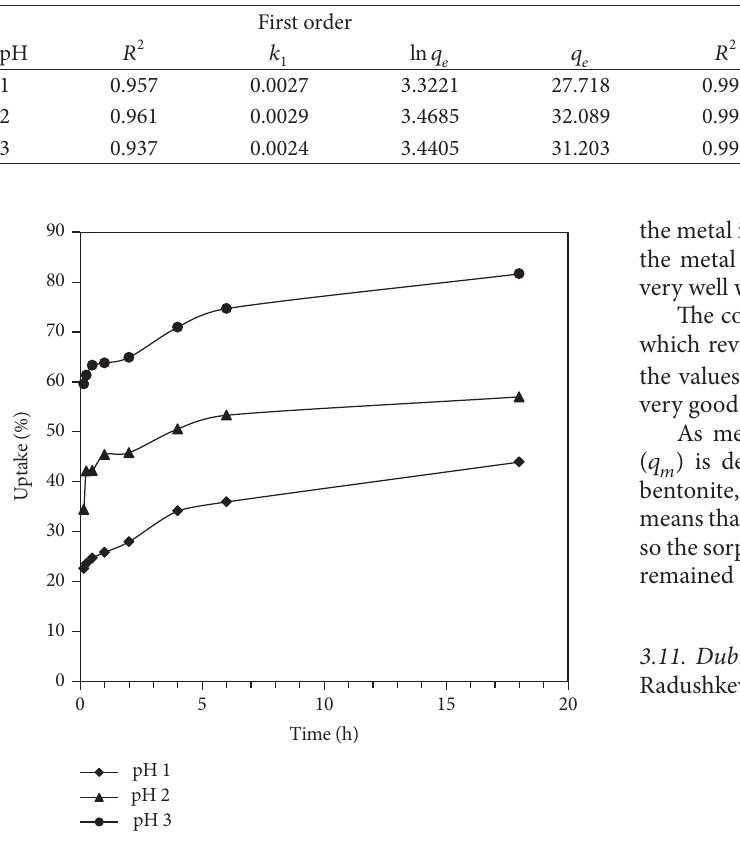
F 5: e S�� images for Raw bentonite and �uri�ed bentonite. �agni�cation � 300 times. T 3: Comparison of sorption rate constants, experimental and calculated kinetics of removal for thorium(IV) by